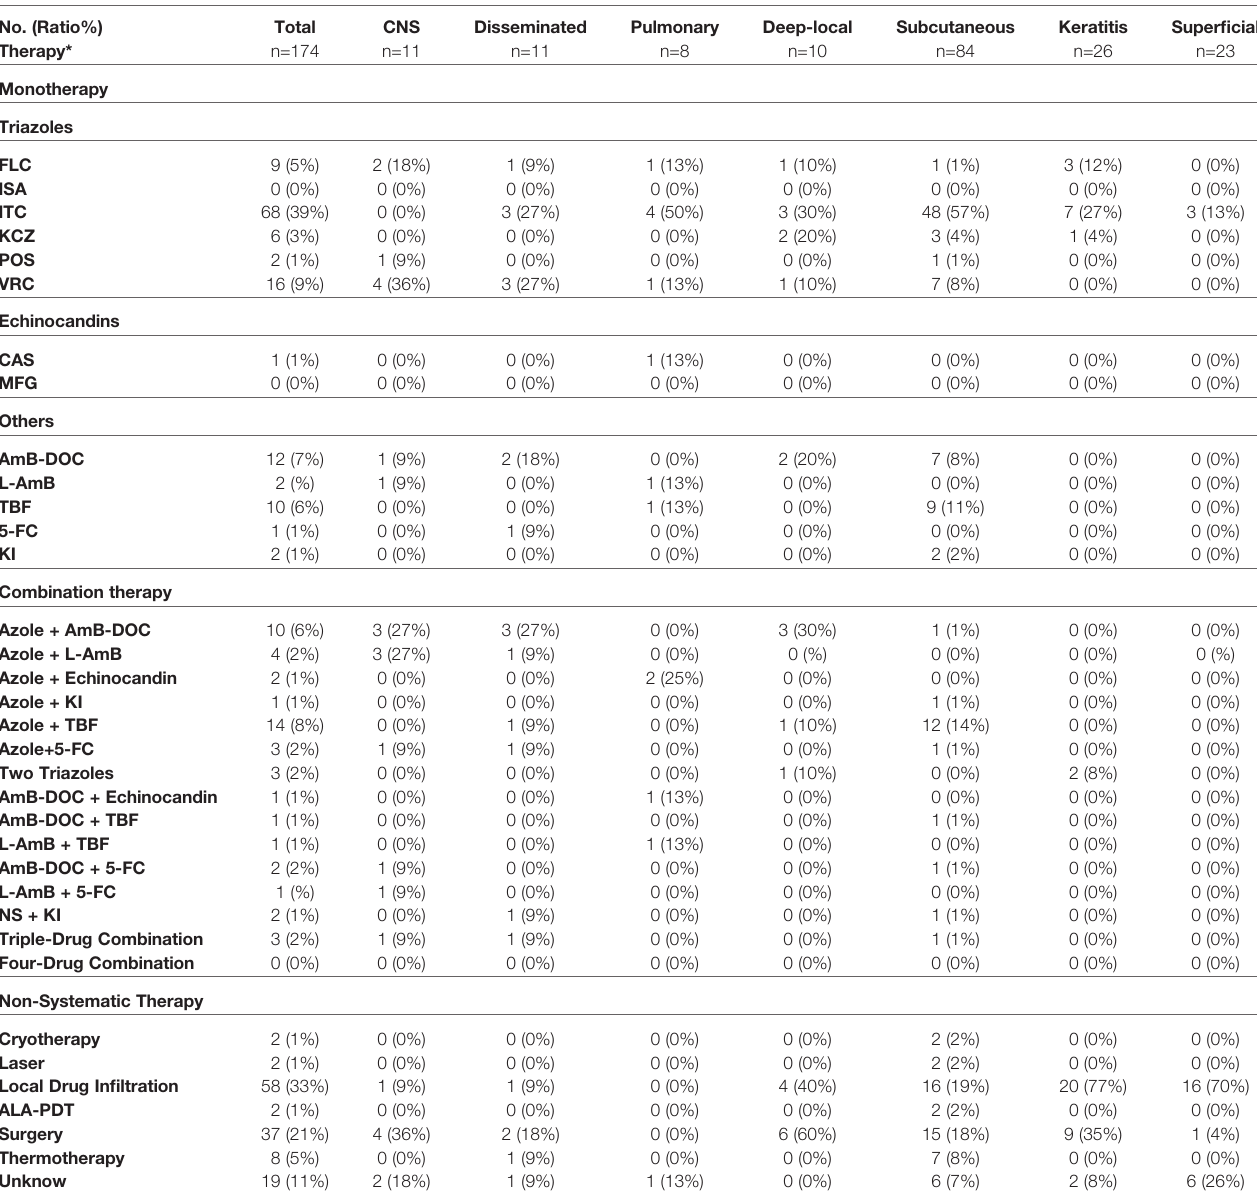
TABLE 8 | Therapy for phaeohyphomycosis in 174 patients in China. No.